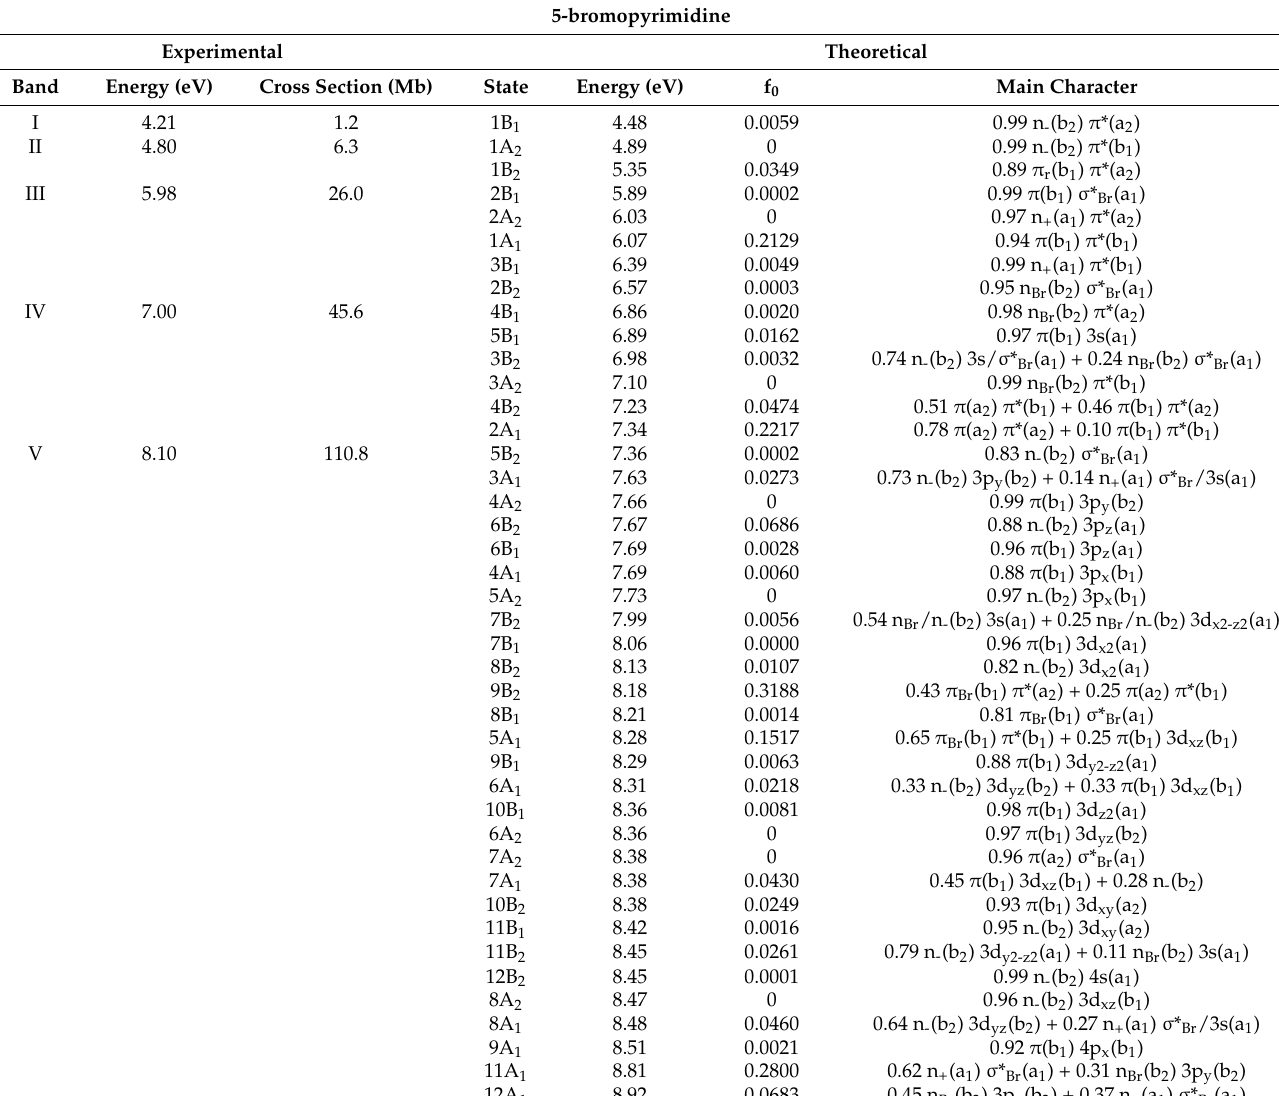
Table 2. Calculated vertical excitation energies and vertical oscillator strengths (f 0 ) of 5-bromopyrimidine, computed at the LYP/aug-cc-pVDZ+2s2p2d level of theory, compared with the experimental data. In the main character column, we present the dominant hole and particle natural transition orbitals and their corresponding occupation